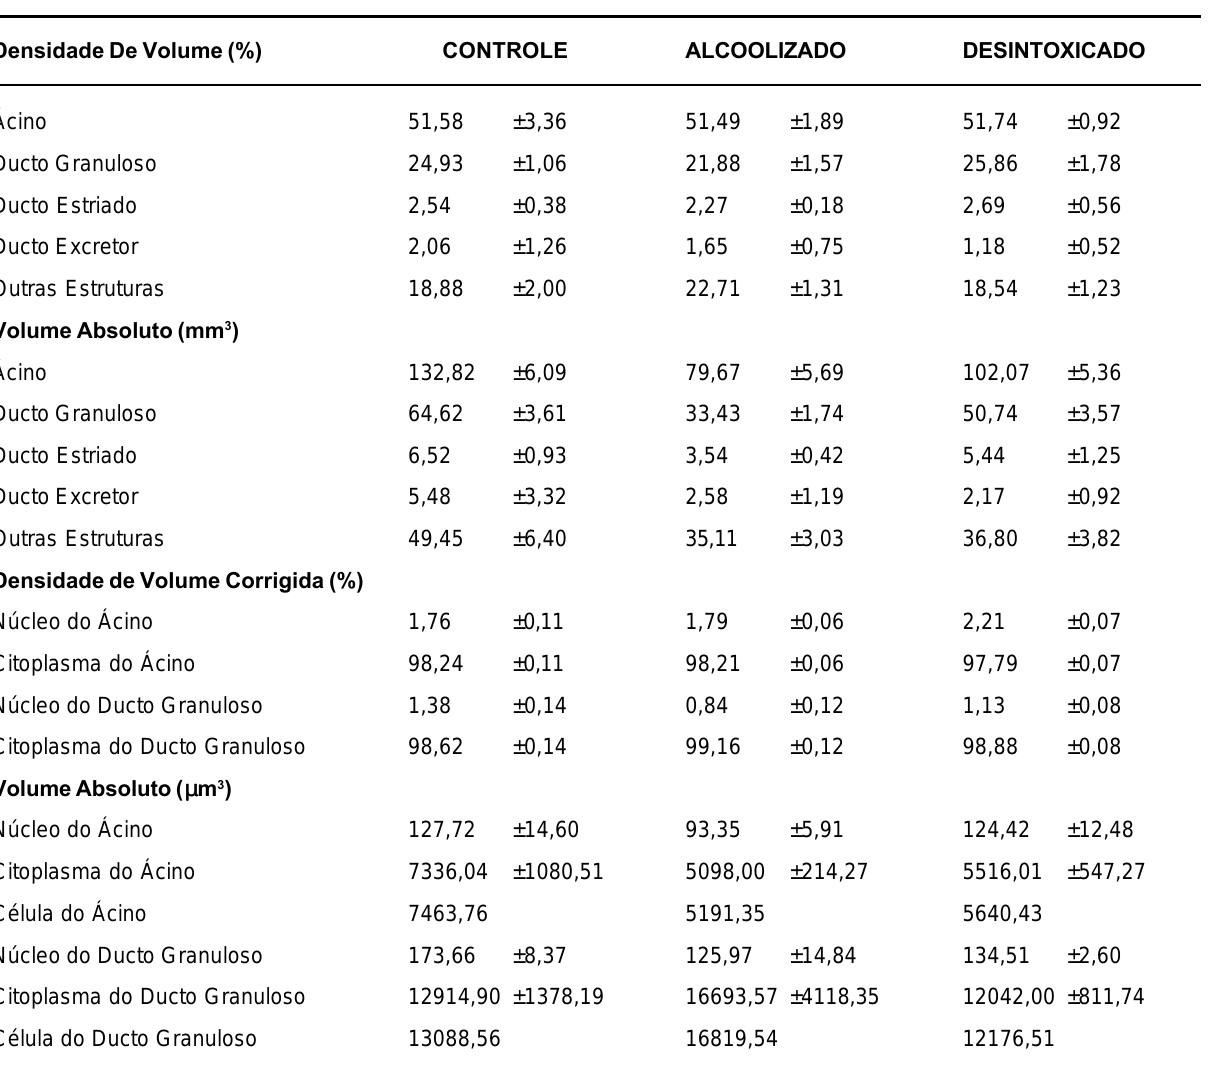
TABELA 2- Resultados morfométricos da glândula submandibular de ratos submetidos ao alcoolismo experimental e desintoxicação